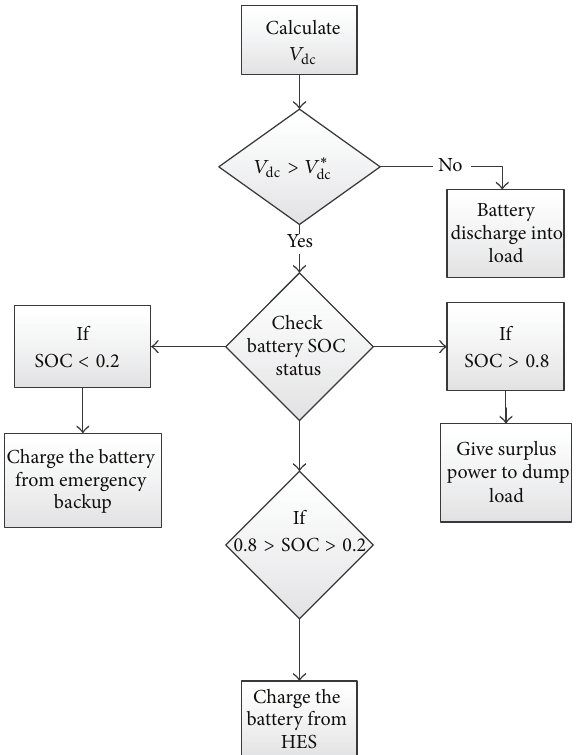
Figure 15: Flowchart for dc-link voltage